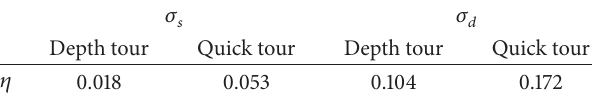
Table 3: Deviation index of satisfaction